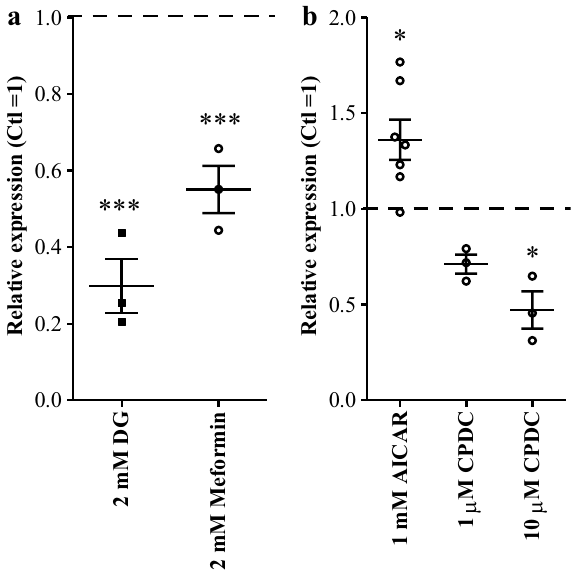
Figure 3. Glucose and energy modulators affect miR1908-5p expression. ( a ) impact of glucose metabolism modulators. ( b ) miR1908-5p expression is sensitive to AMPK regulators. HuH-7 cells were grown in media supplemented with indicated drugs 72 h. RNA was then isolated from lysed cells and miR1908-5p, along miR-16 and RNU48 for normalization, were quantified by qRT-PCR. Normalized values are expressed relative to the vehicle only (Ctl) condition. ANOVA was performed using Dunnett’s post-hoc test. The error bars depict the SEM. * p < 0.05; *** p < 0.001, relative to